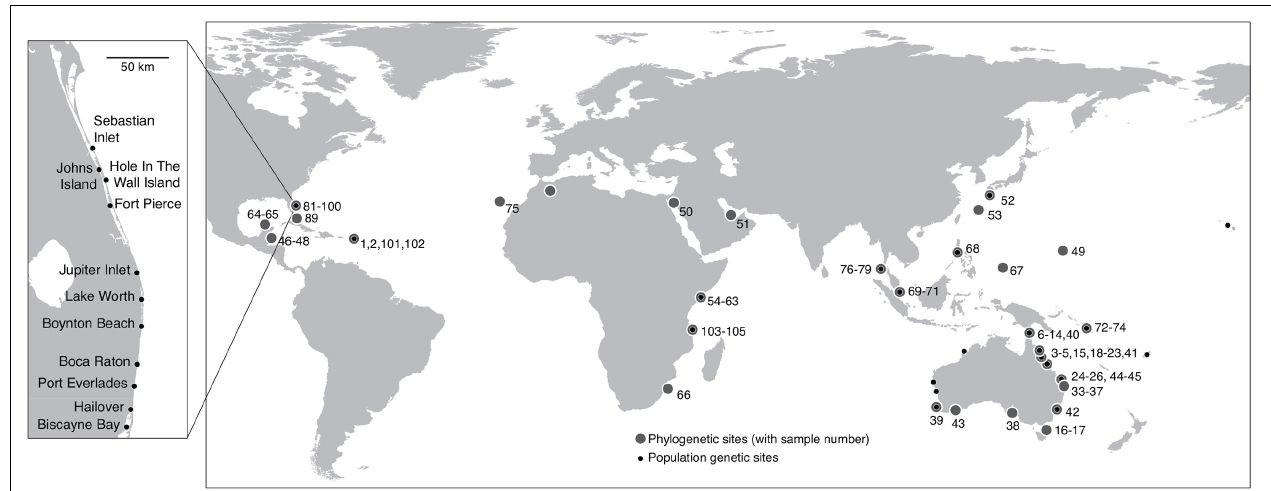
FIGURE 1 | Locations of Halophila samples included in the DNA sequence data sets (large circles). Numbers refer to sample codes used in Supplementary Table 1 . Inset map shows the approximate distributional range of H. johnsonii in Florida, United States indicating collection sites for samples included in this study. Sites used for population genetics analyses are indicated by the small dark circles and have no number assigned. Details of the population genetic samples are in Supplementary Table 5